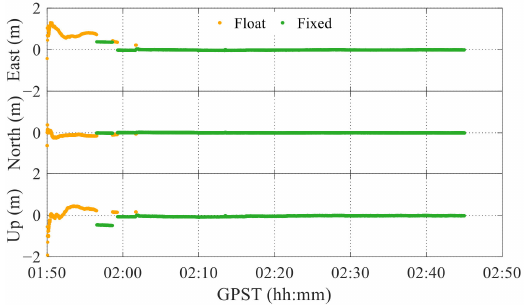
Figure 17. Results of long-term RTK positioning in choke-coil